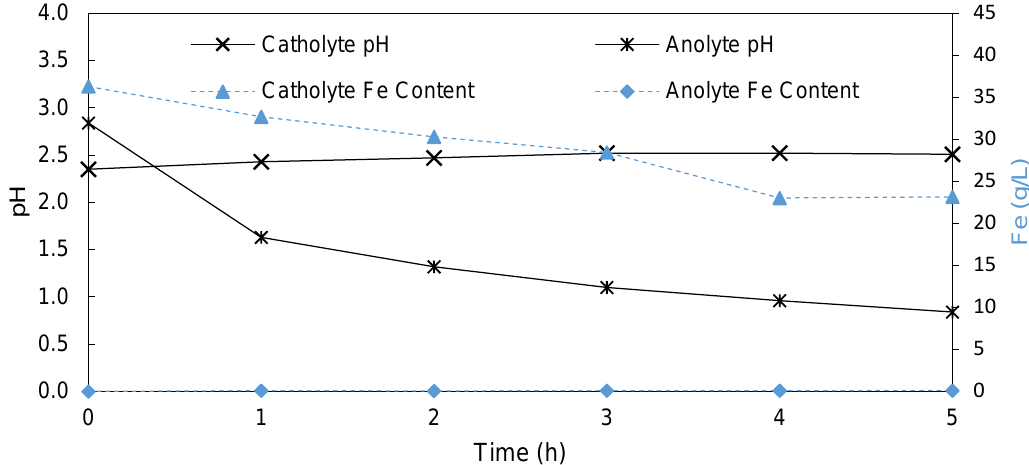
Figure 4. Change in the pH (primary y -axis) and Fe content (secondary y -axis) of the catholyte and anolyte during EW using an AEM (FAB-PK-130) as a separator.